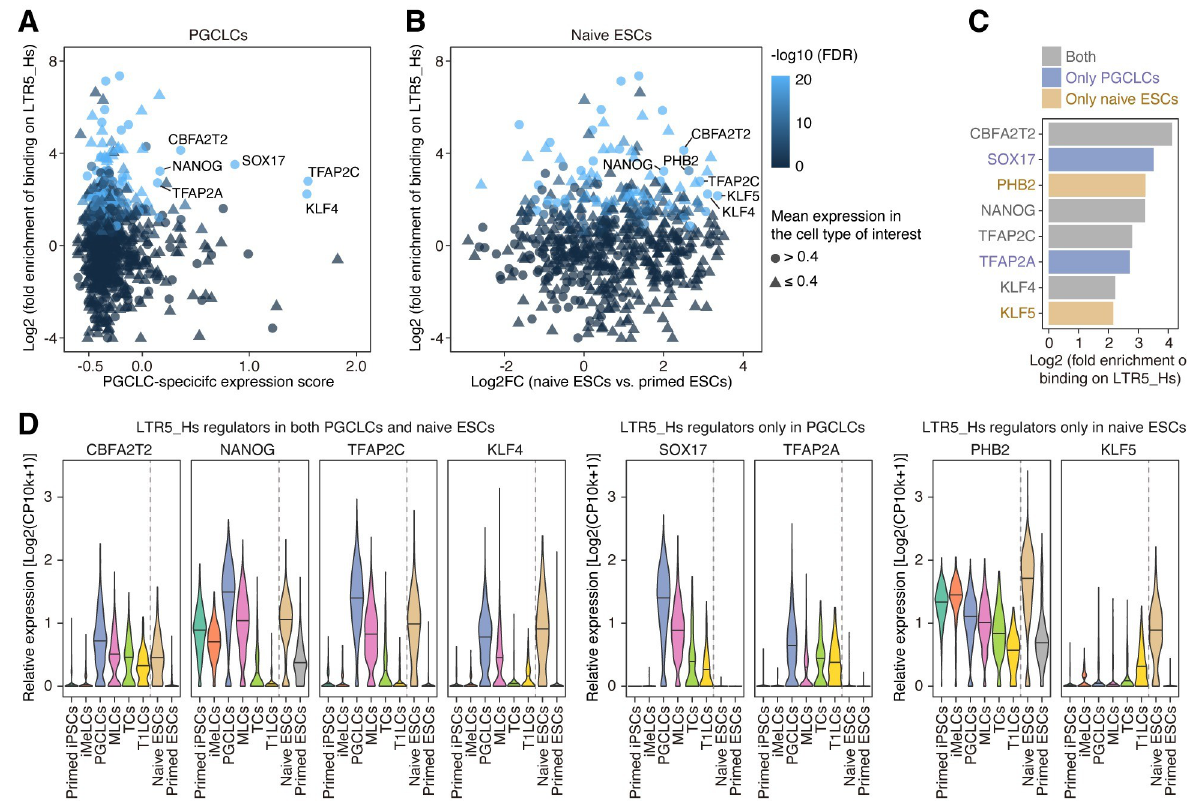
Fig 4. Identification of the potential regulators of LTR5_Hs in PGCLCs and na ï ve ESCs. (A and B) Identification of the TFs that bind to LTR5_Hs and are upregulated in PGCLCs ( A ) and na ï ve ESCs ( B ). For each TF, the statistical enrichment of the binding events on LTR5_Hs was calculated based on the publicly available ChIP-Seq dataset provided by the GTRD [39]. The Y-axis indicates the log2-transformed fold enrichment of the TF-binding events compared to the random expectation. The X-axis indicates the PGCLC-specific expression score ( A ) or the log2 FC of the expression score in na ï ve ESCs vs. primed ESCs ( B ). The symbols are colored according to the statistical significance of the TF-binding enrichment calculated by the genome permutation test. The symbol shape represents the mean expression level in PGCLCs ( A ) and na ï ve ESCs ( B ). The potential regulators of LTR5_Hs are annotated. The potential regulators were defined as the TFs satisfying the following criteria: (i) TFs that exhibited significant binding enrichment on LTR5_Hs (log2 fold enrichment > 2; FDR < 0.05; binding events > 20); (ii) for regulators in PGCLCs, TFs that were specifically upregulated in PGCLCs (the top 10% TFs with respect to the PGCLC-specific expression score; mean relative expression (log2[CP10k+1] > 0.4 in PGCLCs); and (iii) for regulators in na ï ve ESCs, TFs that were specifically upregulated in na ï ve ESCs (log2 FC > 2; FDR < 0.05; mean relative expression > 0.4 in na ï ve ESCs). (C) Classification of the potential LTR5_Hs regulators. The X-axis indicates the log2-transformed fold enrichment of the TF-binding events. (D) Expression patterns of TFs identified as potential LTR5_Hs